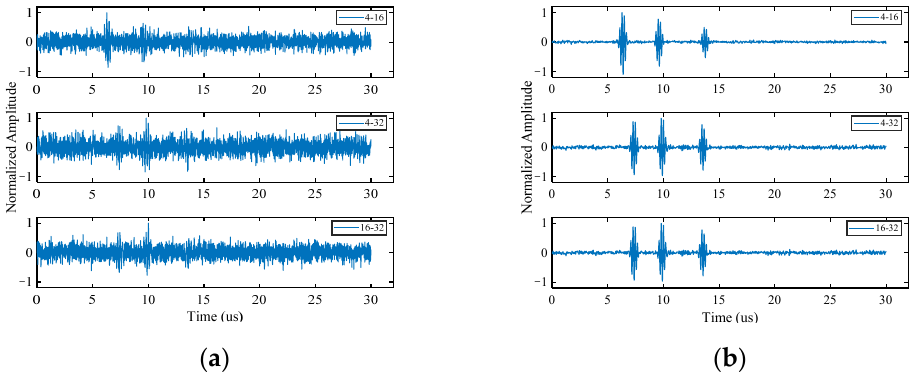
Figure 7. Time domain waveforms of simulated signal. ( a ) Before noise reduction; ( b ) after noise reduction.